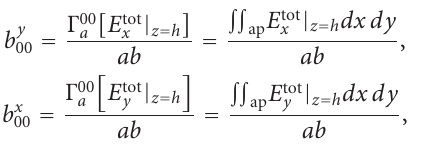
Figure 7: CFEM convergence for the square patch AMC in Figure 6. Reflection phase angle at normal incidence θ = 180 ◦ is shown for di ff erent CFEM modes and HFSS methods. Substrate thickness is 1 . 57mm. “tet” represents the number of